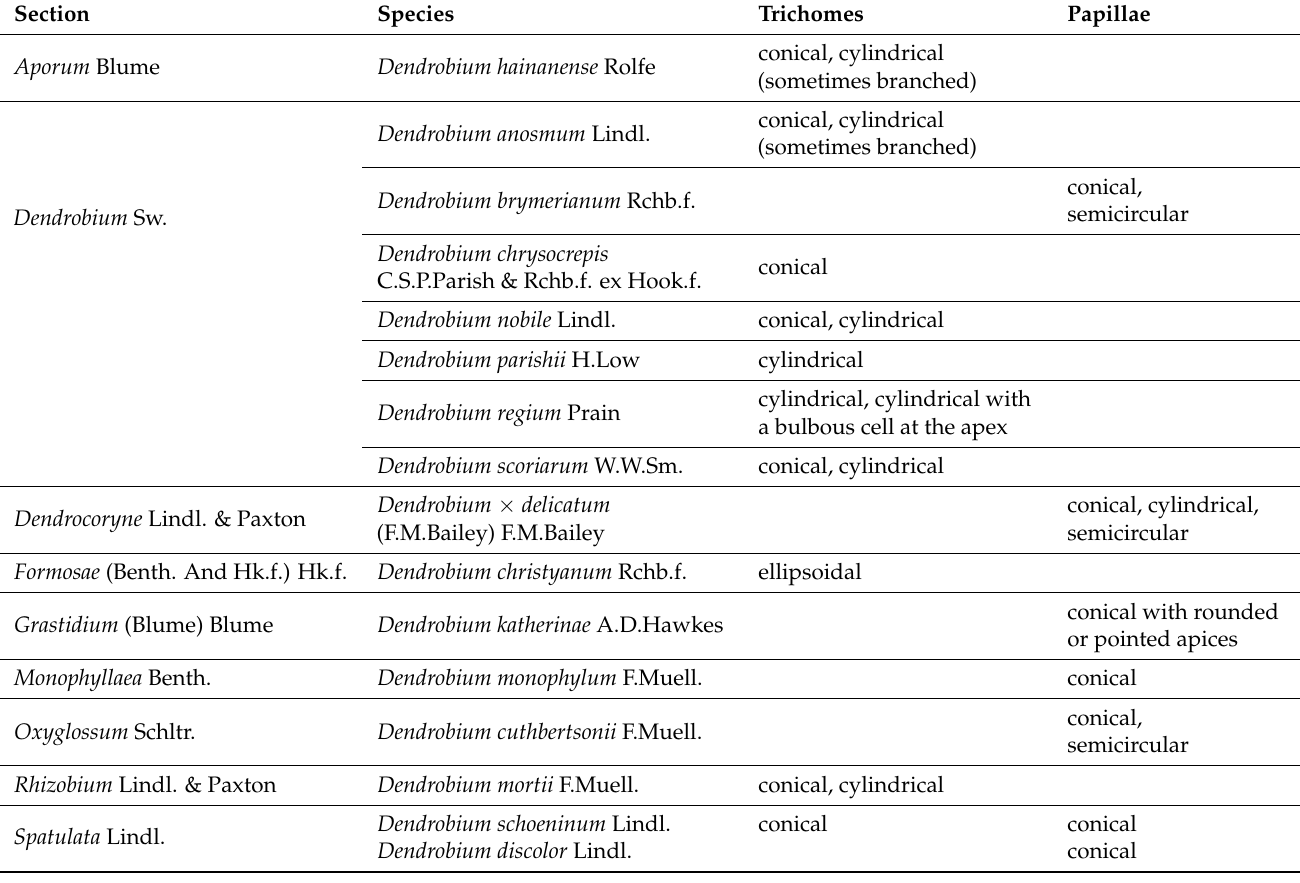
Table 1. Types of labellar structures found in all Dendrobium species researched in this paper, which have trichomes or papillae.